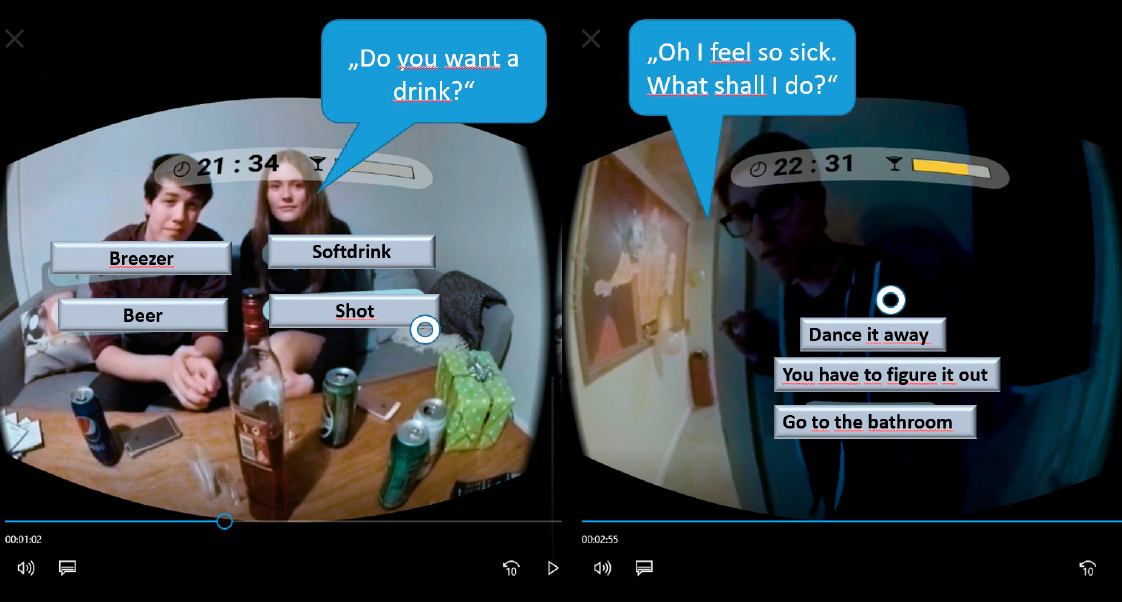
Figure 1. Screenshots illustrating two different decision points in VR FestLab.